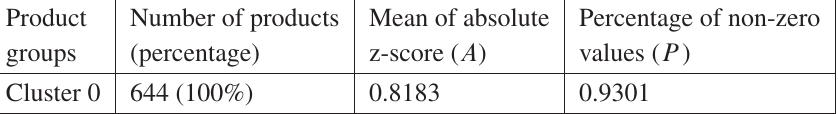
Table 11. Tier-2 monthly stability analysis with the EM algorithm in 2005.